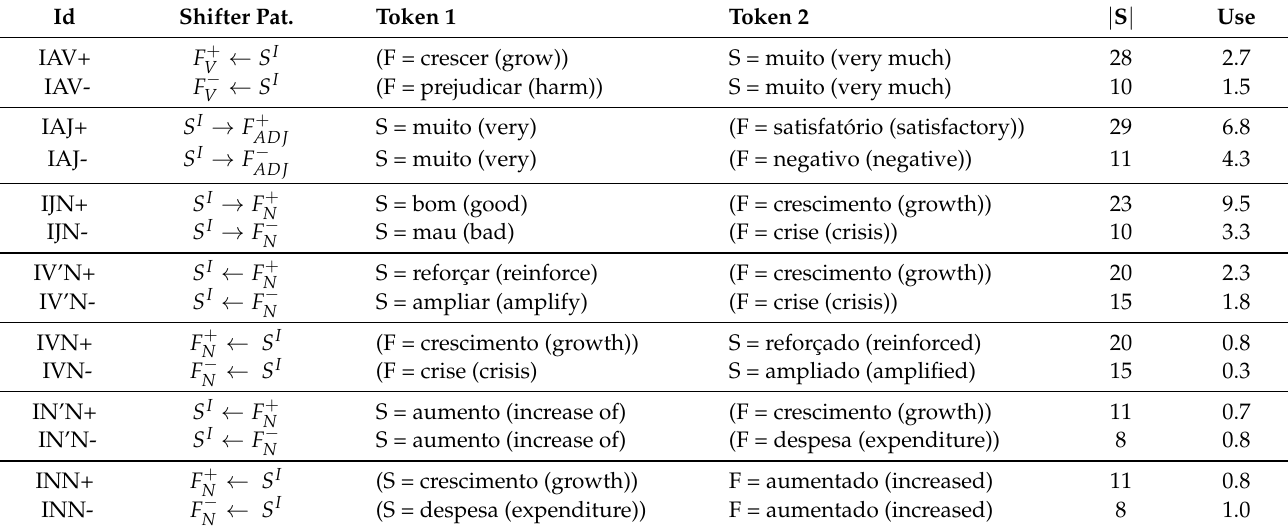
Table 5. Some shifter patterns that include